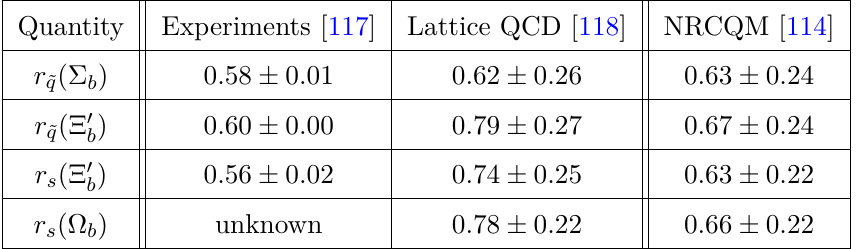
Table 3 . Comparisons of the NRCQM results for the r q ( B ) to available experimental data and lattice QCD evaluations. For the B -meson mass splittings, we use the measured values reported in